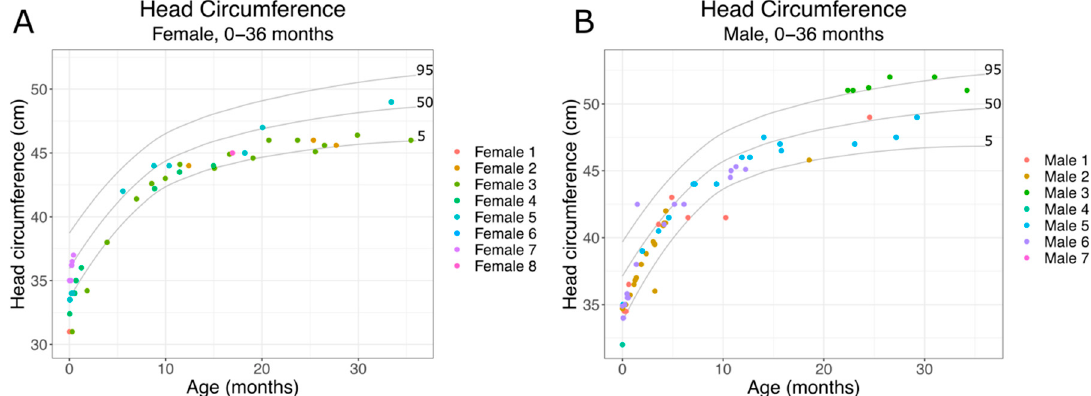
Figure 1. SLC13A5 Citrate Transporter Disorder patient head circumference : head circumference from 0–36 months in female ( A ) and male ( B ) patients are shown with the 95th, 50th and 5th percentile head circumferences from the CDC growth charts.